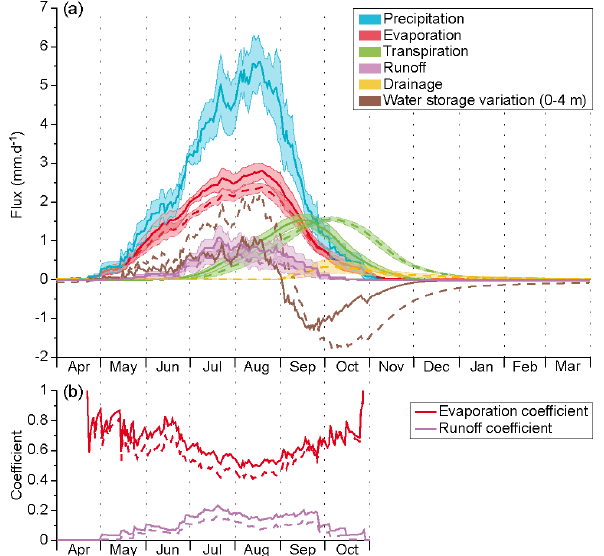
Figure 6. Estimated mean seasonal courses of water cycle com- ponents, for fallow (solid lines) and millet (dashed lines) plots: (a) fluxes and rate of storage change in 0–4m soil column; (b) ra- tios of above evaporation and runoff means to rainfall. Means are computed across years and over a 30-day running window. Light- colored intervals in (a) show a variation of ± 1 standard estimation error around the estimated mean (not shown for storage change, for legibility).